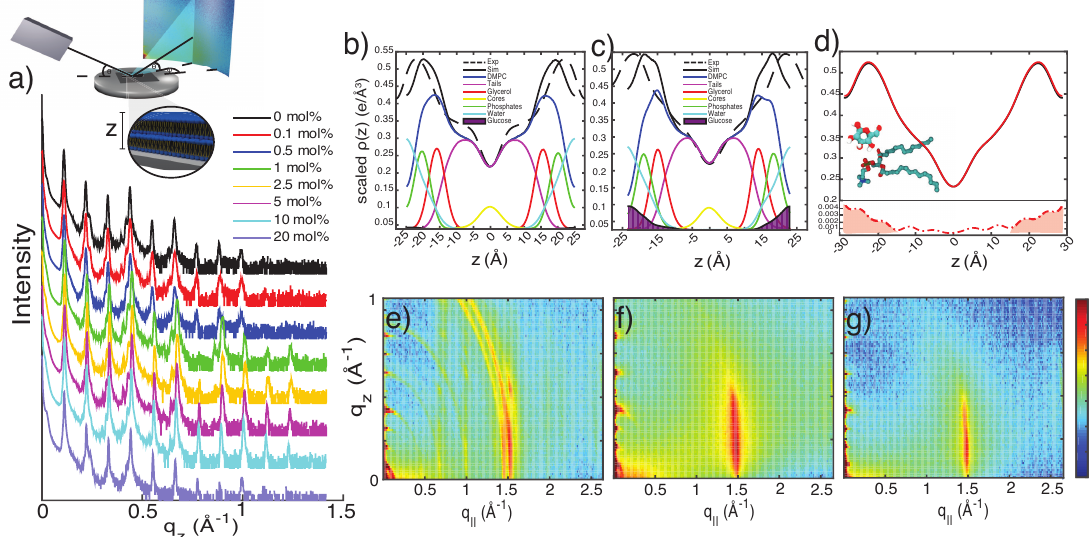
Figure 2. ( a ) Out-of-plane reflectivity data for DMPC bilayers with glucose concentrations from 0.1 mol% to 20 mol%. Inset shows a schematic of the experimental setup. ( b , c ) Comparison of electron density profiles (EDPs) from X-ray diffraction data (dashed black) and MD simulations (solid black) at 1 mol% ( b ) and 20 mol% ( c ) glucose. ( d ) Comparison of EDPs from X-ray diffraction data of a pure DMPC membrane and 1 mol% glucose. ( e – g ) Two-dimensional diffraction data for pure DMPC ( e ), 1mol% glucose ( f ), and 20 mol% glucose ( g